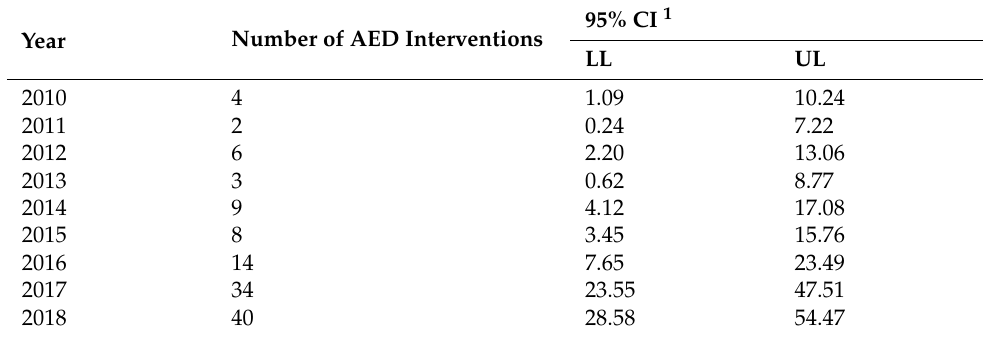
Table 3. Frequency of AED interventions by year.